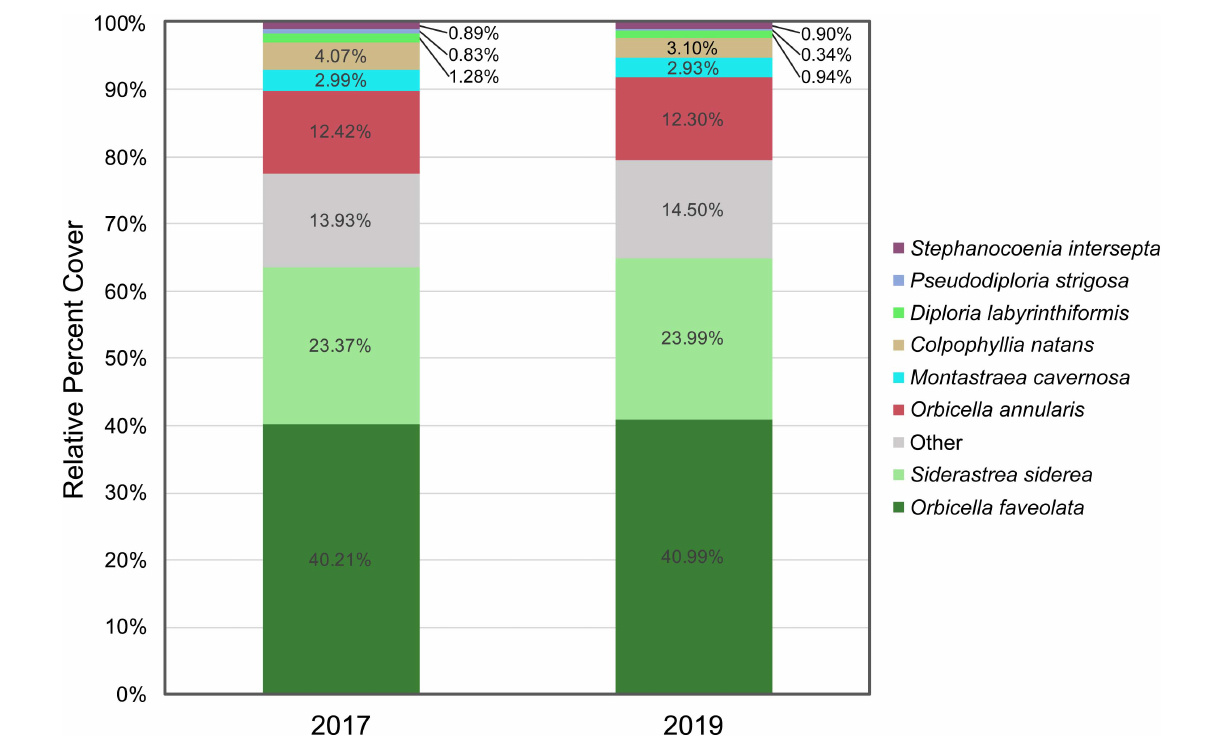
FIGURE 4 | Species composition from 2017 to 2019, represented as relative percent cover of the top eight most abundant species, with all other species grouped as Other. Species ranked according to decreasing absolute percent